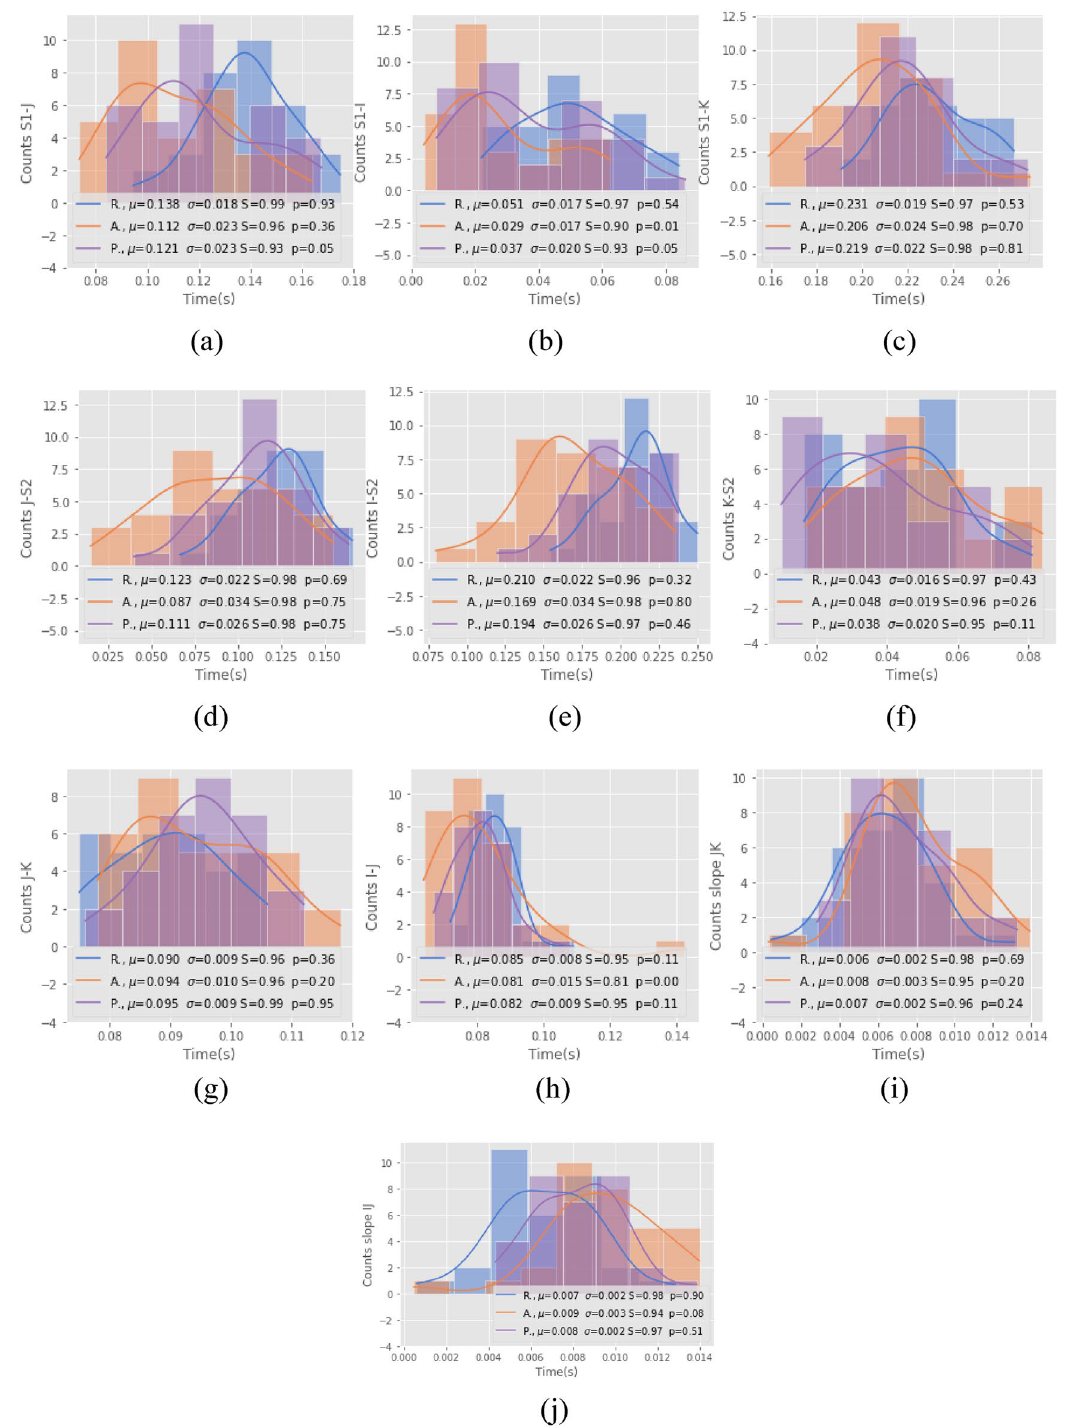
Figure 4. Histograms of the features according to the subject state: R = Rest, A = Activity, P = Post-activity, μ = Mean, σ = Std. dev., S = Shapiro test for normality, and p = p-value of the Shapiro test. Sample: 21